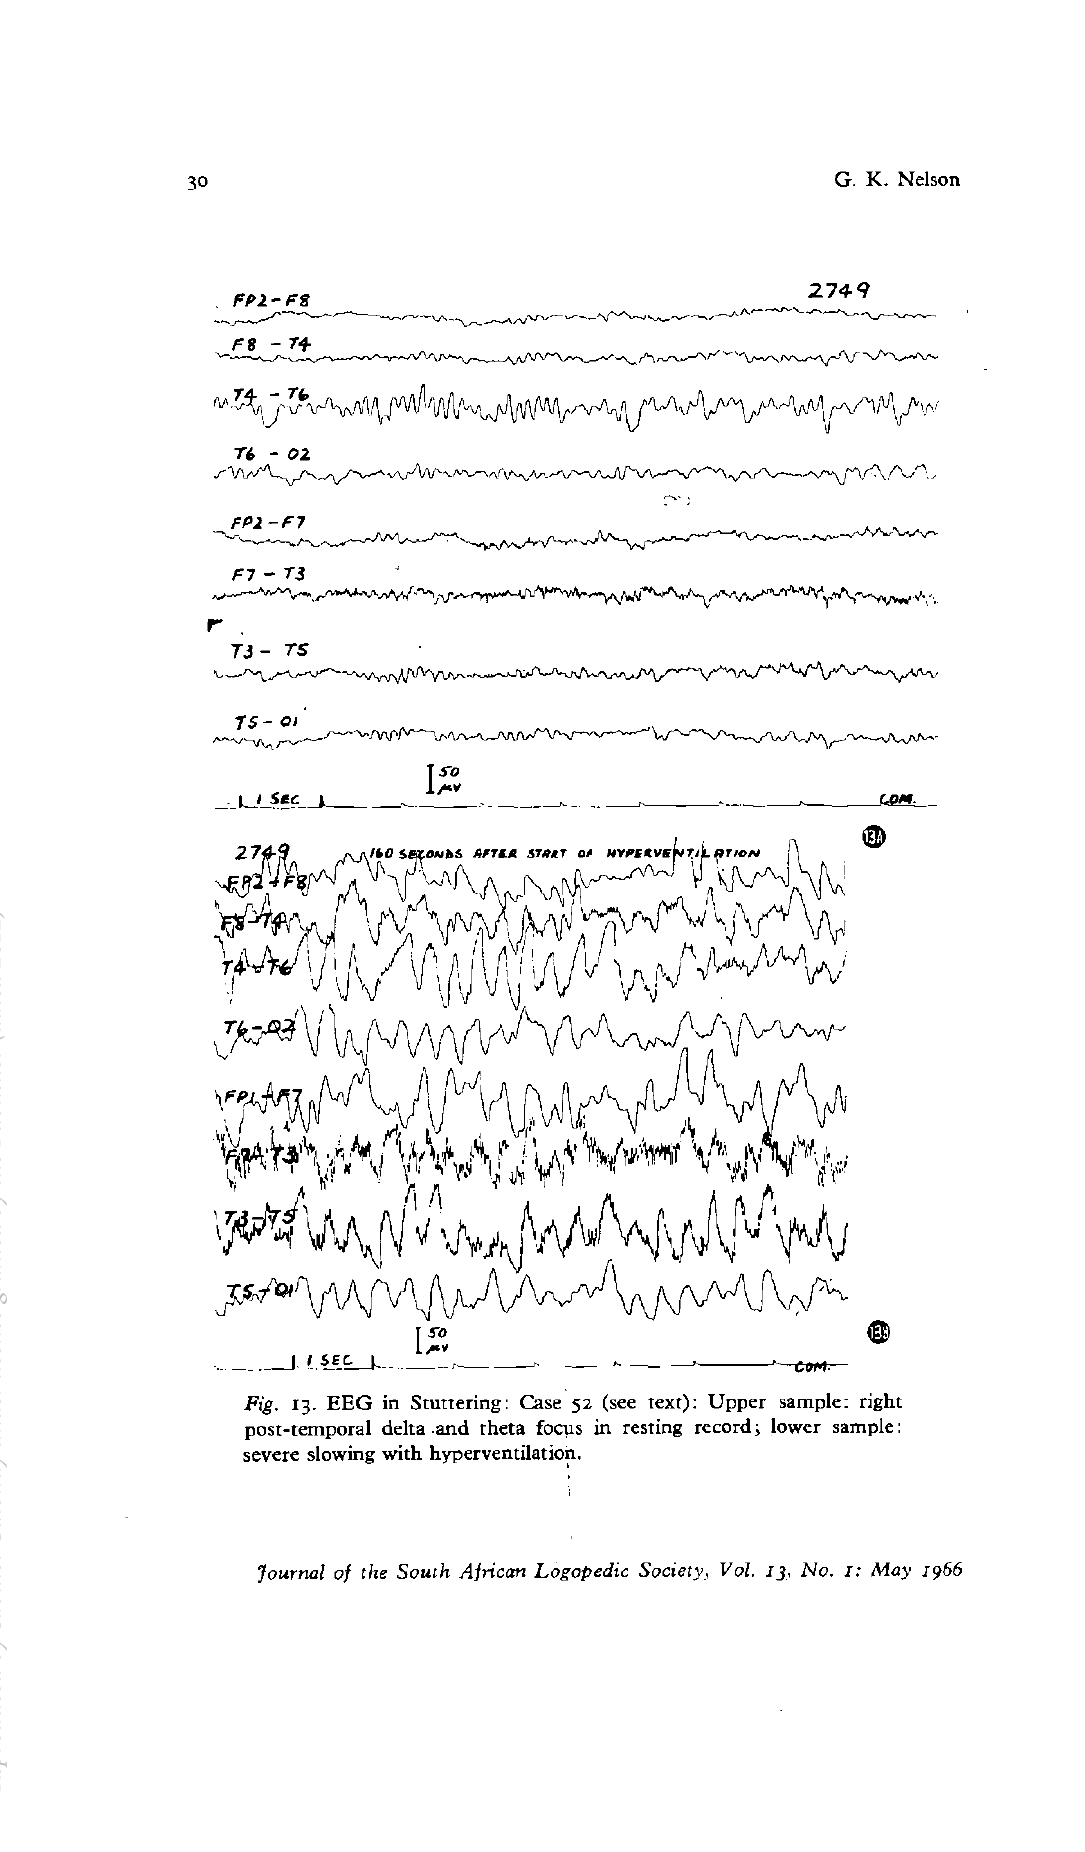
Fi£. 13. EEG in Stuttering: Case 52 (see text): Upper sample: right post-temporal delta and theta focus in resting record; lower sample: severe slowing with